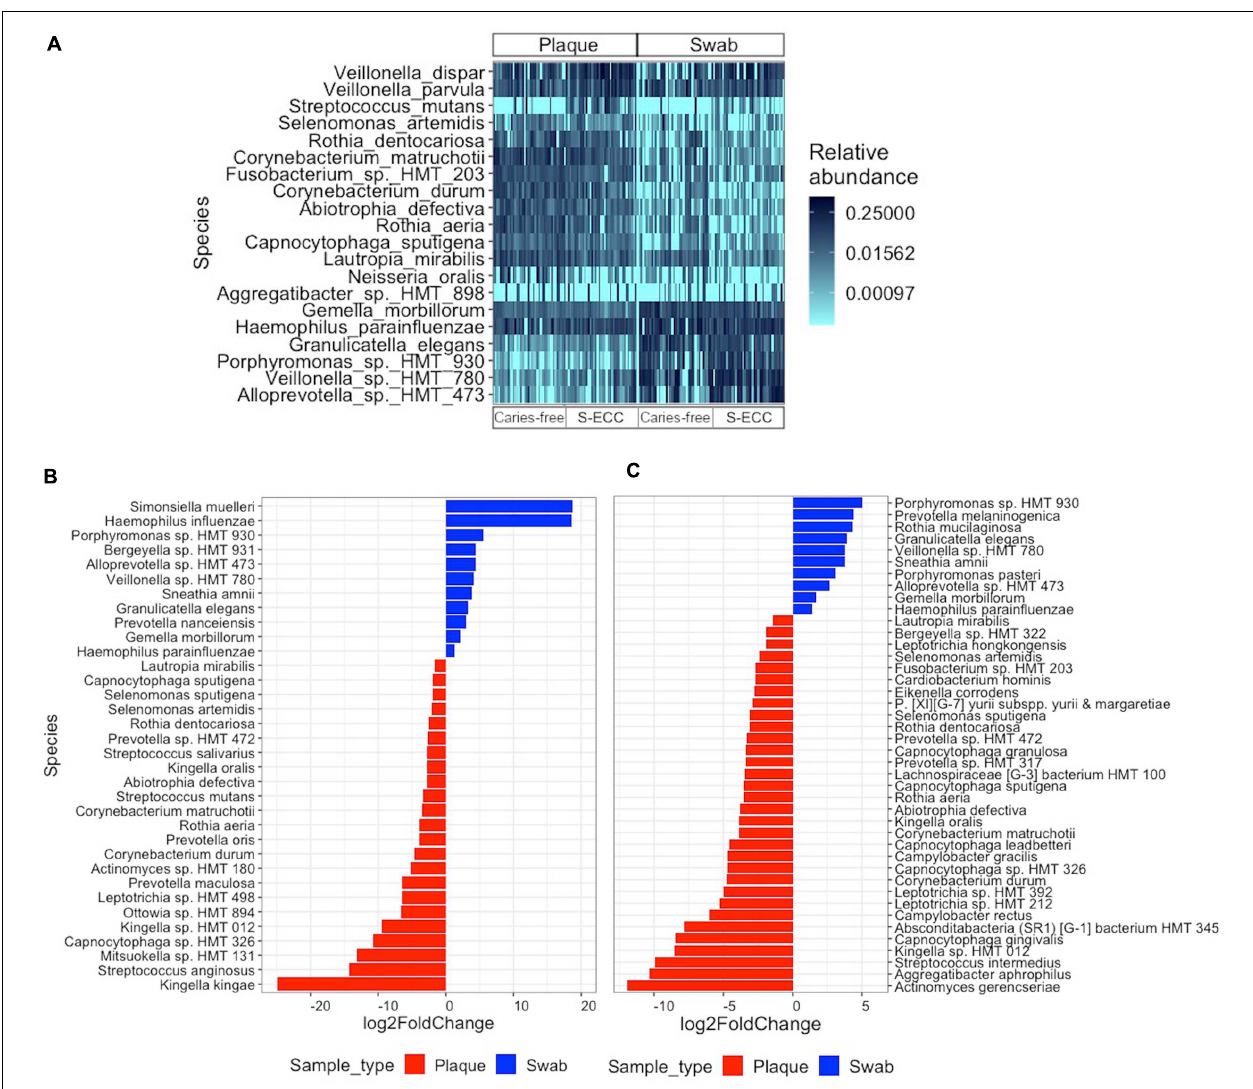
FIGURE 3 | Differential abundance of bacterial species. (A) Heatmap showing the relative abundance of the top 20 bacterial species identified in all dental plaque and oral swab samples. (B,C) Relative fold change in the abundance of bacterial species in (B) samples from children with S-ECC, and (C) samples from caries-free children, according to sample type. The differential abundance of the bacterial species was tested using the DESeq2 negative binomial Wald test. (B,C) All species listed have an FDR adjusted P < 0.05. S-ECC, severe early childhood caries.